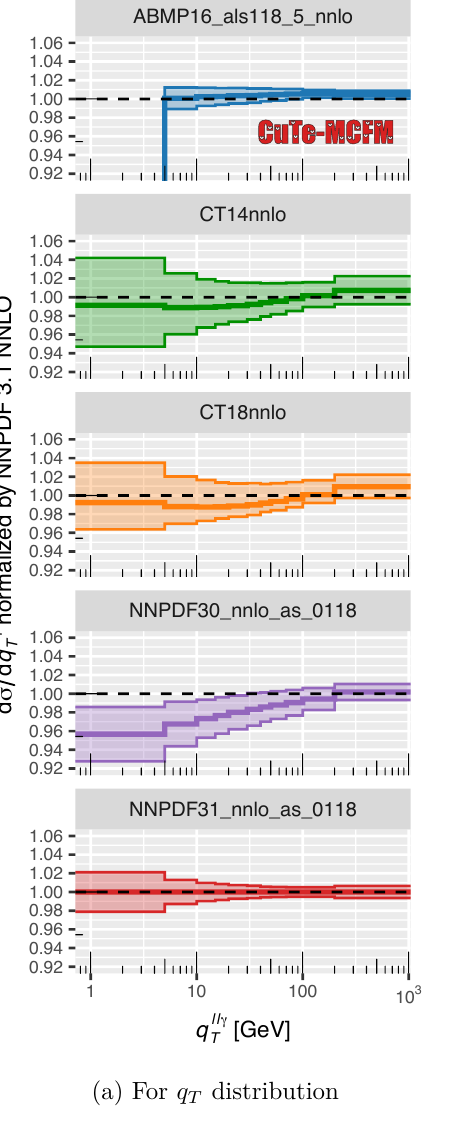
Figure 26. PDF uncertainties for the q T (a) and ∆ φ (b) distributions in Zγ production correspond- ing to the distributions with experimental selection cuts in figure 23 and figure 24, respectively. The ABMP16 grid is not defined below µ = 4 . 47 GeV , which can be seen as breakdown in the